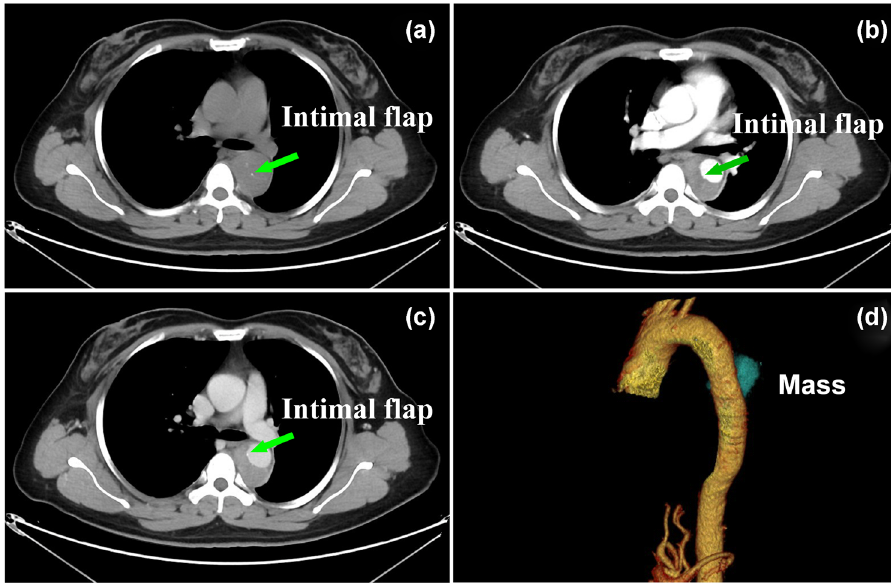
Figure 1: Axial nonenhanced CT images ( a ) showing a crescent - shaped thickening of aortic wall with the same attenuation as that of the lumen and intimal fl ap. CTA ( c and d ) showing an intimal fl ap and expanded false lumen with slight enhancement, and correspond reconstructed image ( d ) showing a mass - like false lumen, which was interpreted by radiologists as IMH.